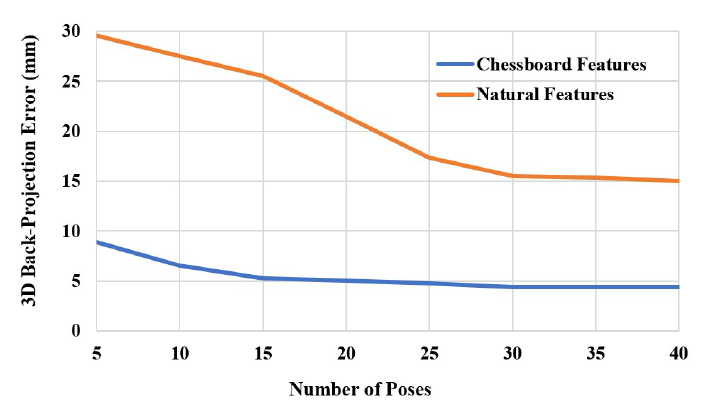
Figure 8. 3D back-projection error after optimization related to number of